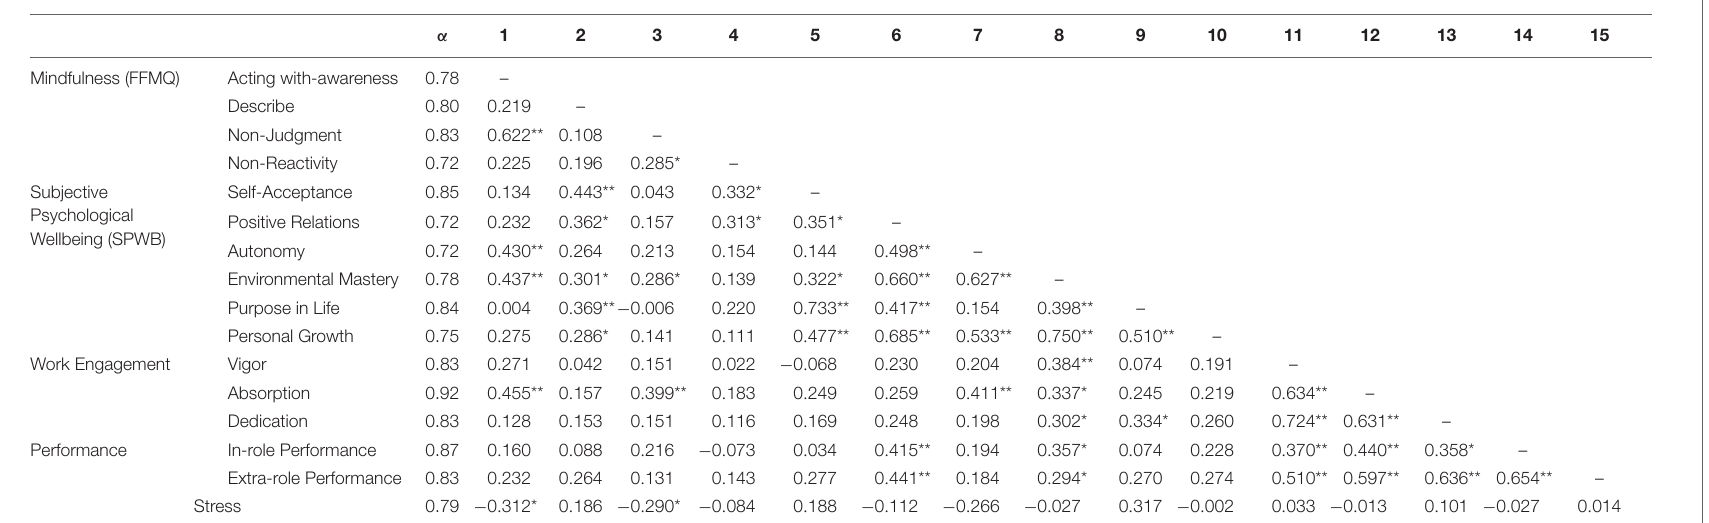
TABLE 4 | Cronbach’s α and correlations for all sub scales at post-intervention